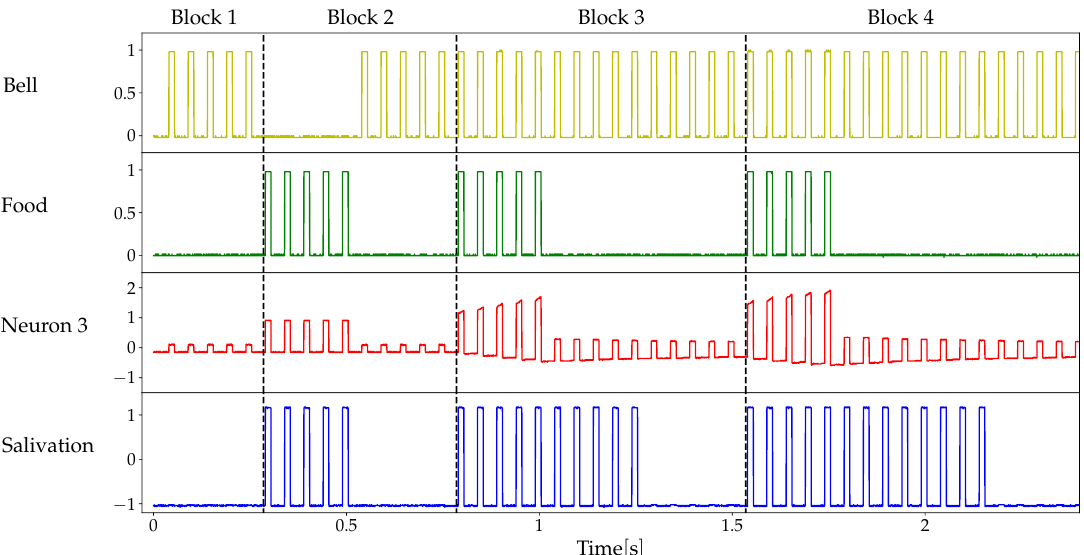
Figure 10. Pavlovian conditioning. When present, stimuli V f (food) and V b (bell) are represented 1 V-high square waves with a 20 Hz frequency and 30% duty cycle. Parameters of the memristor model: